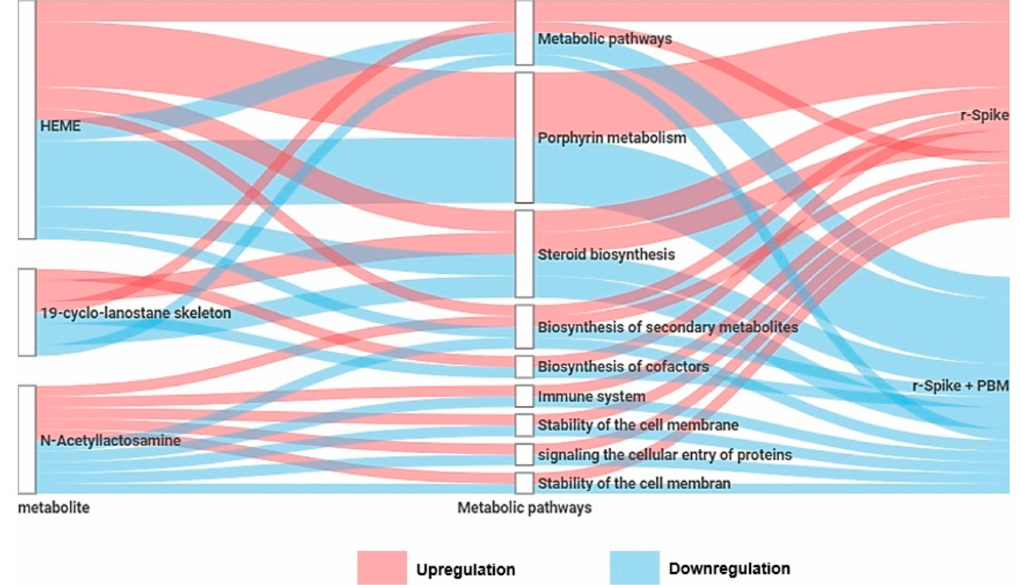
Figure 7. Summary of the metabolites and metabolic pathways differentially expressed between the recombinant Spike protein (rSpike) and PBM treatment.